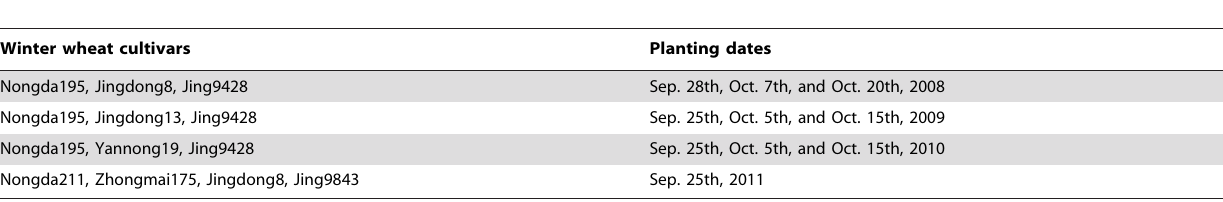
Table 1. Winter wheat cultivars and planting dates were selected in the 2008, 2009, 2010 and 2011.